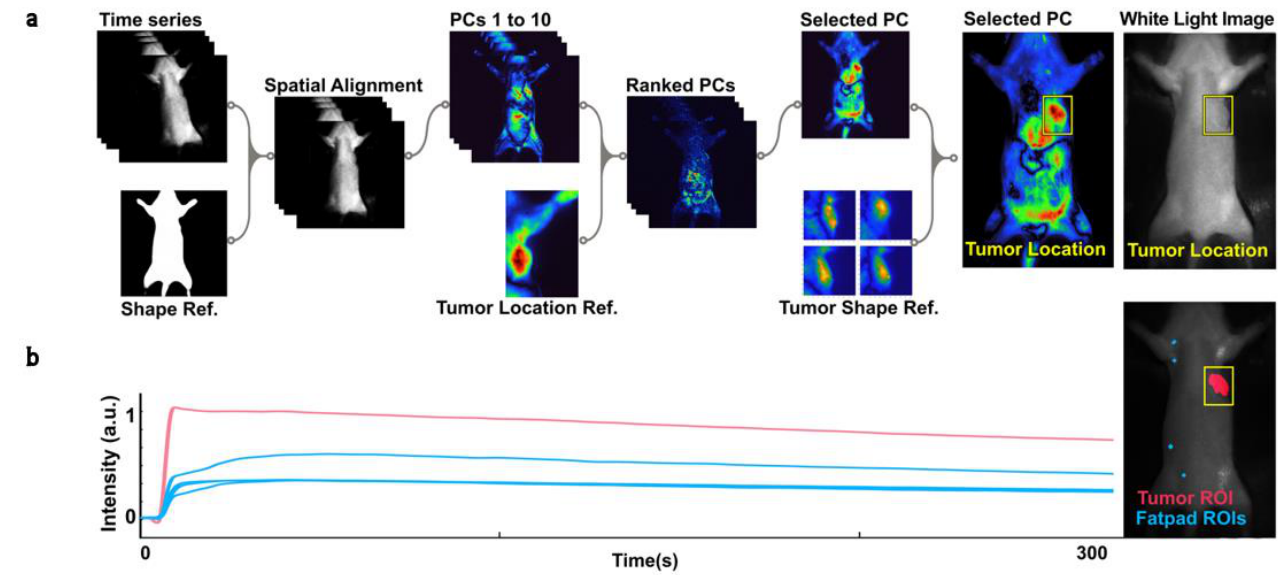
Figure 2. ( a ) Diagram of the process for detecting tumors and generating regions of interest (ROIs). The ROI detection module consists of three steps: spatial alignment, PCA ranking and selection, and ROI selection and masking. First, NIR time series data are registered to a reference image using a rigid body transformation. Next, PC reconstructions are ranked based on their 2D cross-correlation with a reference image featuring a clearly visible tumor. The tumor ’ s location and a bounding box (shown in yellow) are estimated based on the 2D cross-correlation score of the selected PC and reference images featuring different tumors. The tumor ’ s boundaries are enhanced and distinguished from the background through morphological dilation and thresholding. The resulting ROI is used to mask the NIR time series data. ( b ) Plot of the mean intensity of ICG biodistribution fluorescence kinetic data over 300 s for the tumor (red) and four fat pads (blue), normalized to a range of 0 to 1.